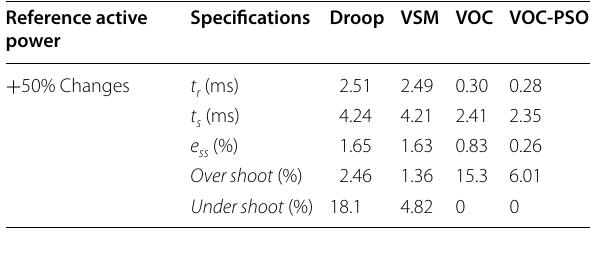
Table 4 Dynamic enactment of Droop control, VSM, VOC, and VOC-PSO Reference active power